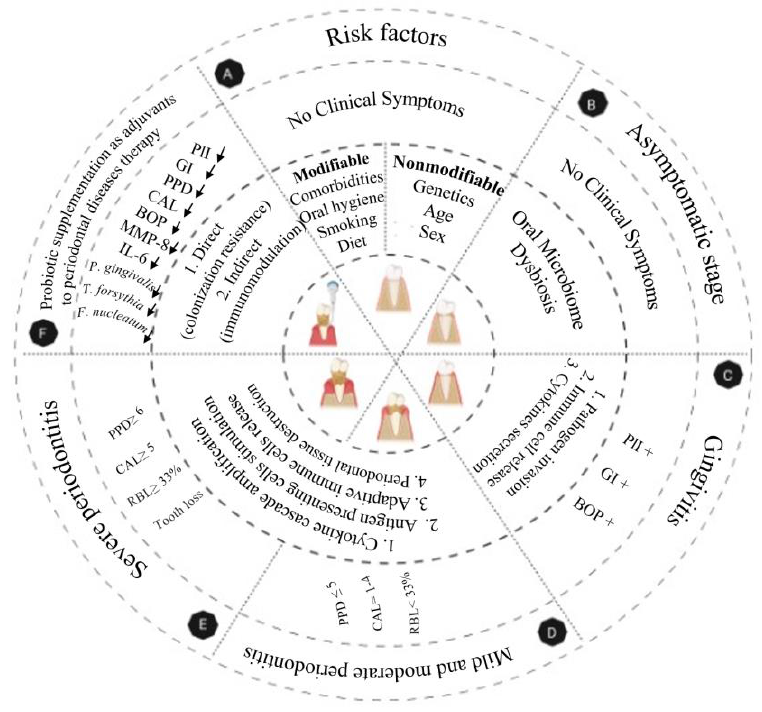
Figure 1. Etiology and pathogenesis of periodontal diseases. Periodontal disease is initiated by dis- rupting the commensal oral microbiome–host homeostasis. ( A ). Both modifiable and nonmodifiable risk factors impact the oral microbiome composition and disrupt homeostasis between the host and microbiome. Modifiable risk factors include diet, smoking, oral hygiene, and comorbidities (such as